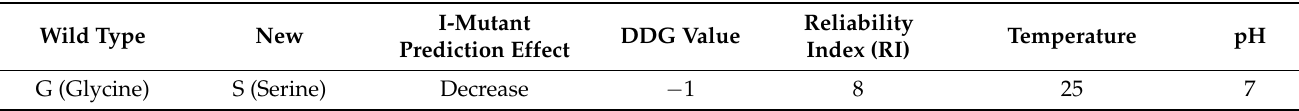
Table 8. mexA Prediction result of I-Mutant software.